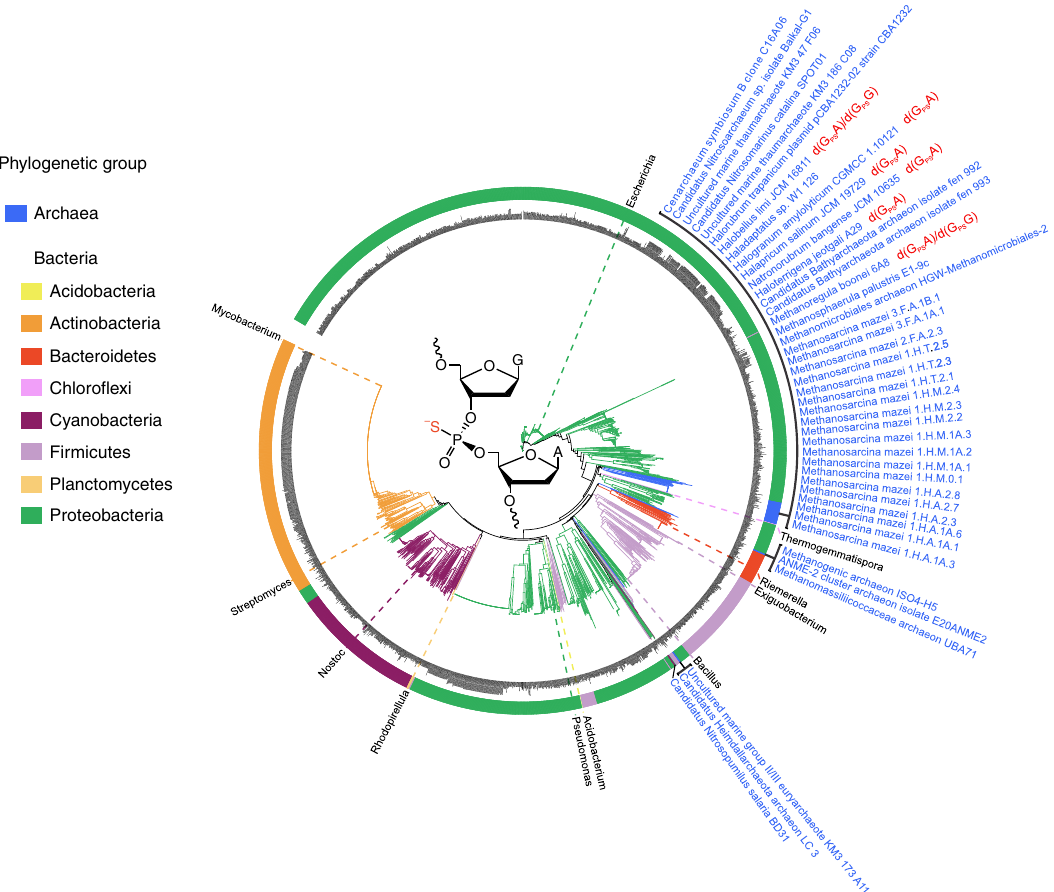
Fig. 1 Maximum likelihood phylogeny of 2642 homologues of the H. jeotgali A29 DndCD identi fi ed in Archaea and Bacteria. The strain names of 42 archaea, as well as the phosphorothioate (PT) sequence contexts identi fi ed in this study are displayed as noted. Each prokaryotic phylum is represented in a distinct colour (see the legend). Bacterial strain names are also provided in Supplementary Data 1. For clarity, at least one familiar genus per colour segment were labelled. The structure of PT-modi fi ed d (G PS A) in the R P con fi guration is shown in the centre of the tree. Source data are provided as